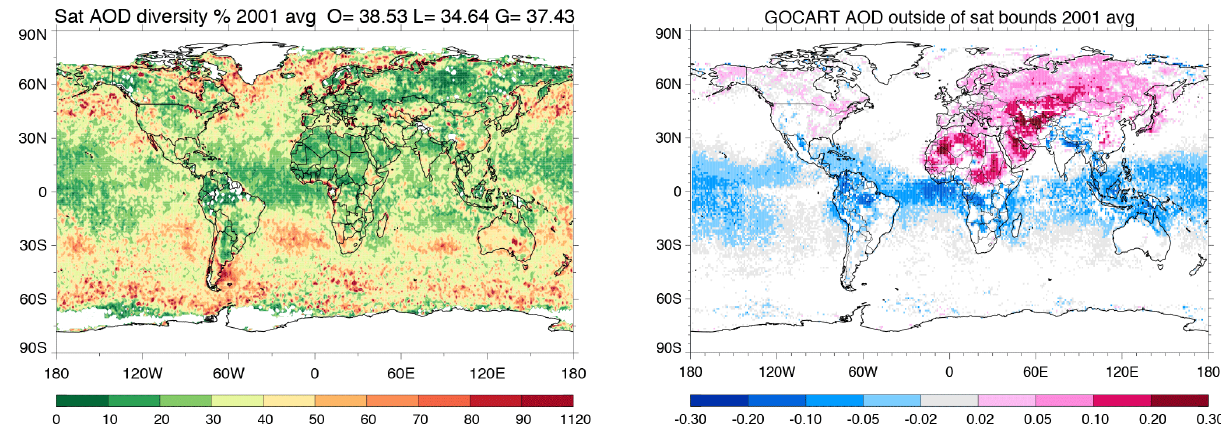
Fig. 5. (left) Satellite AOD diversity, defined as 1/2 (AOD max − AOD min ) / AOD median × 100%, for all available satellite annual mean AOD data points shown in Fig. 4, and (right) GOCART-simulated AOD that are outside of the satellite AOD